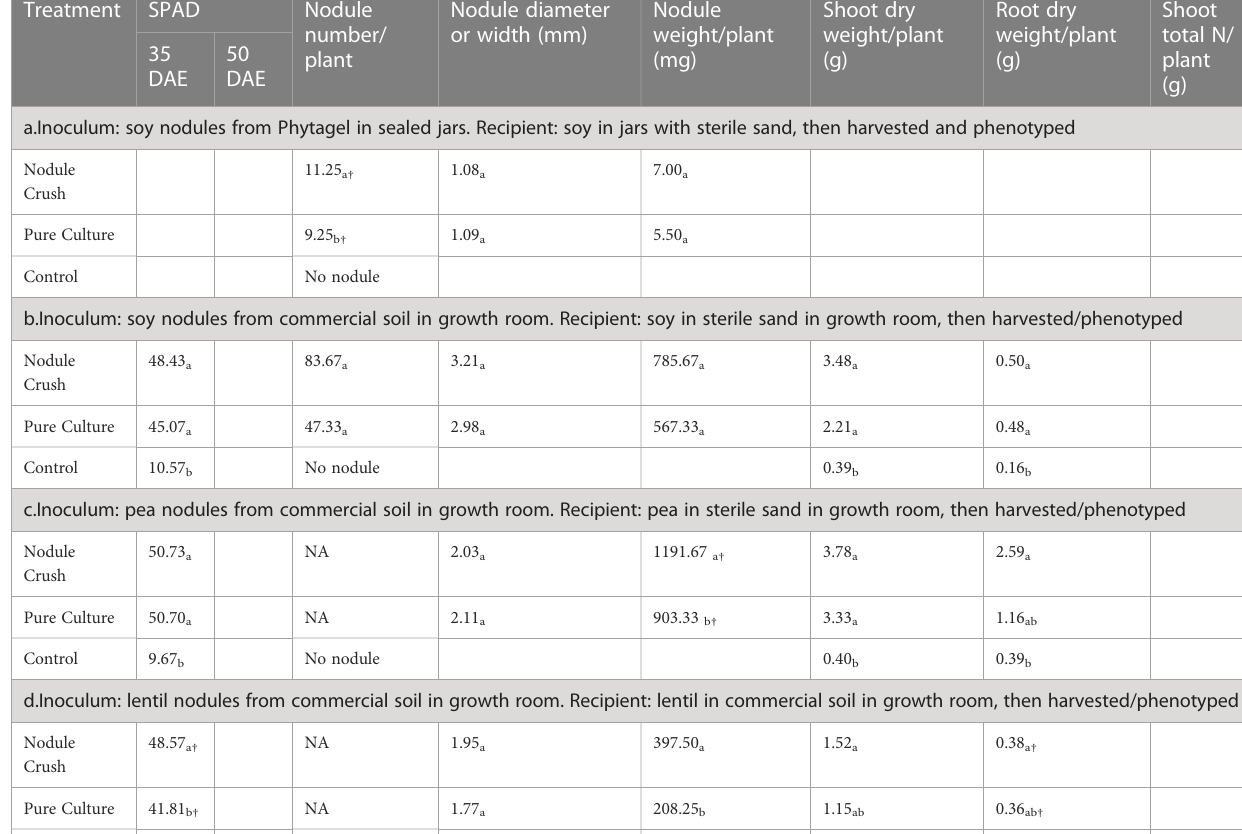
Shoot dry weight/plant (g)